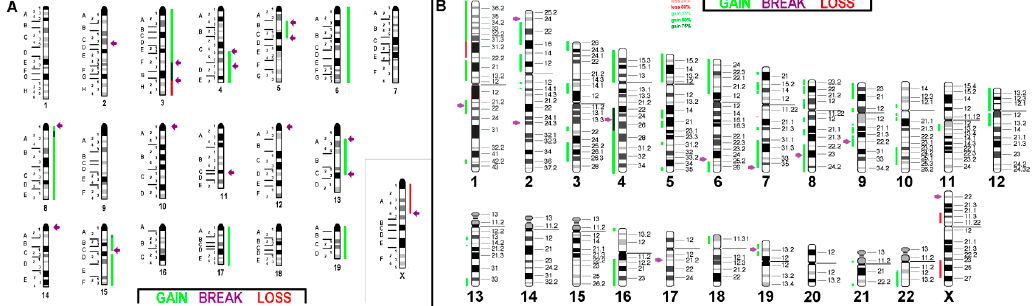
Figure 5. aCGH results for the triploid murine BC cell line EMT6/P ( A ) and its projection onto the human genome ( B ): For more details, see legend of Figure 4.